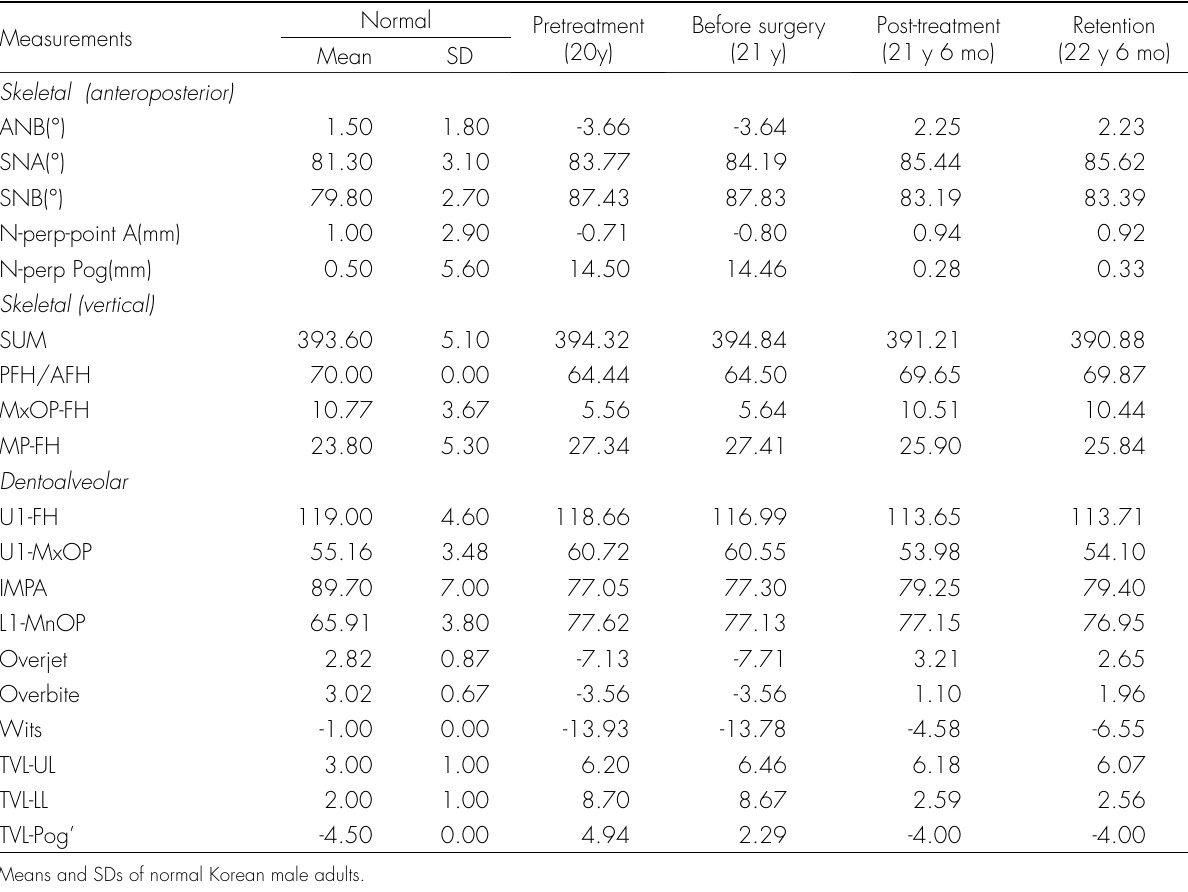
Table I. Cephalometric measurements.